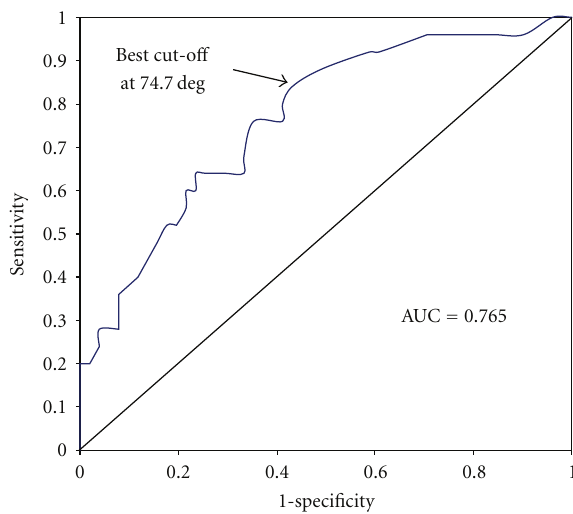
Figure 1: Receiver operator characteristics (ROC) curves for Rapid α -Angle predicting transfusion of any blood product.